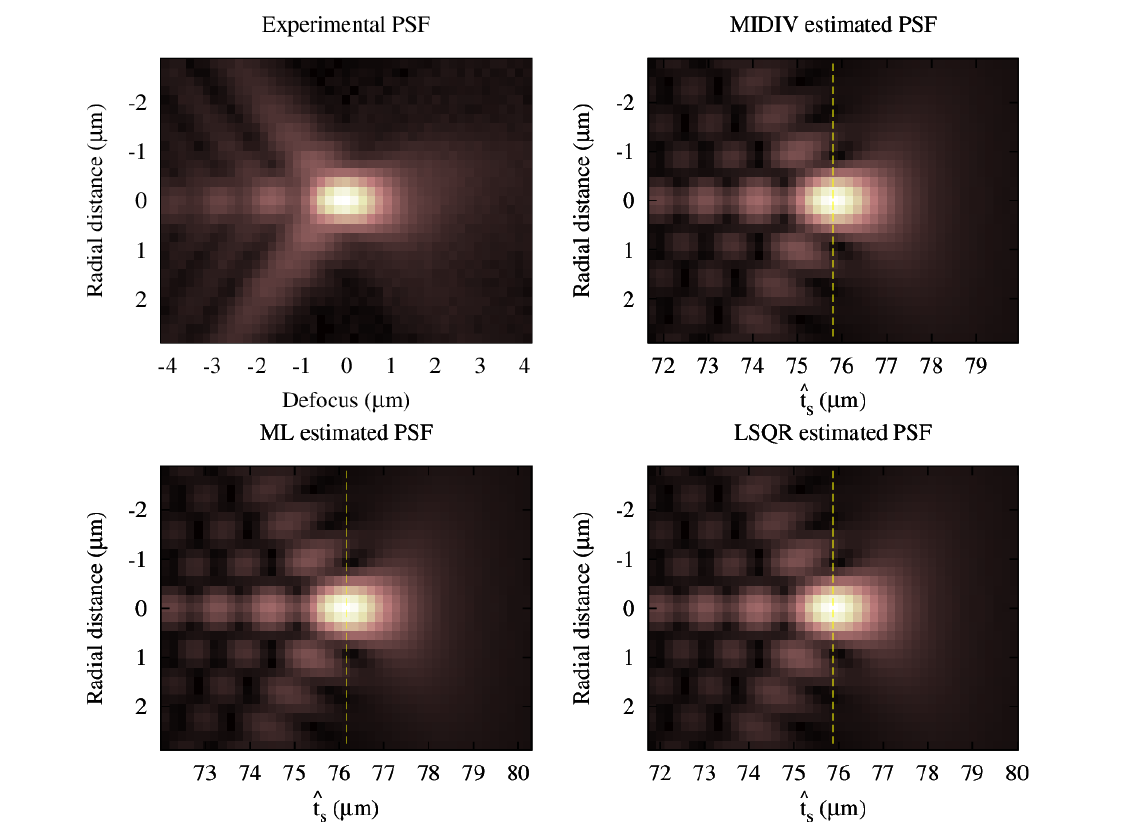
Figure 11. Pseudocolor images of 45 × 31 pixels. Upper left, image of fluorescent nanobead of 0.170 ± 0.005 µ m in diameter. In the counter clockwise direction: synthetic PSFs obtained by the estimations of the axial t s by MIDIV, LSQR and ML,